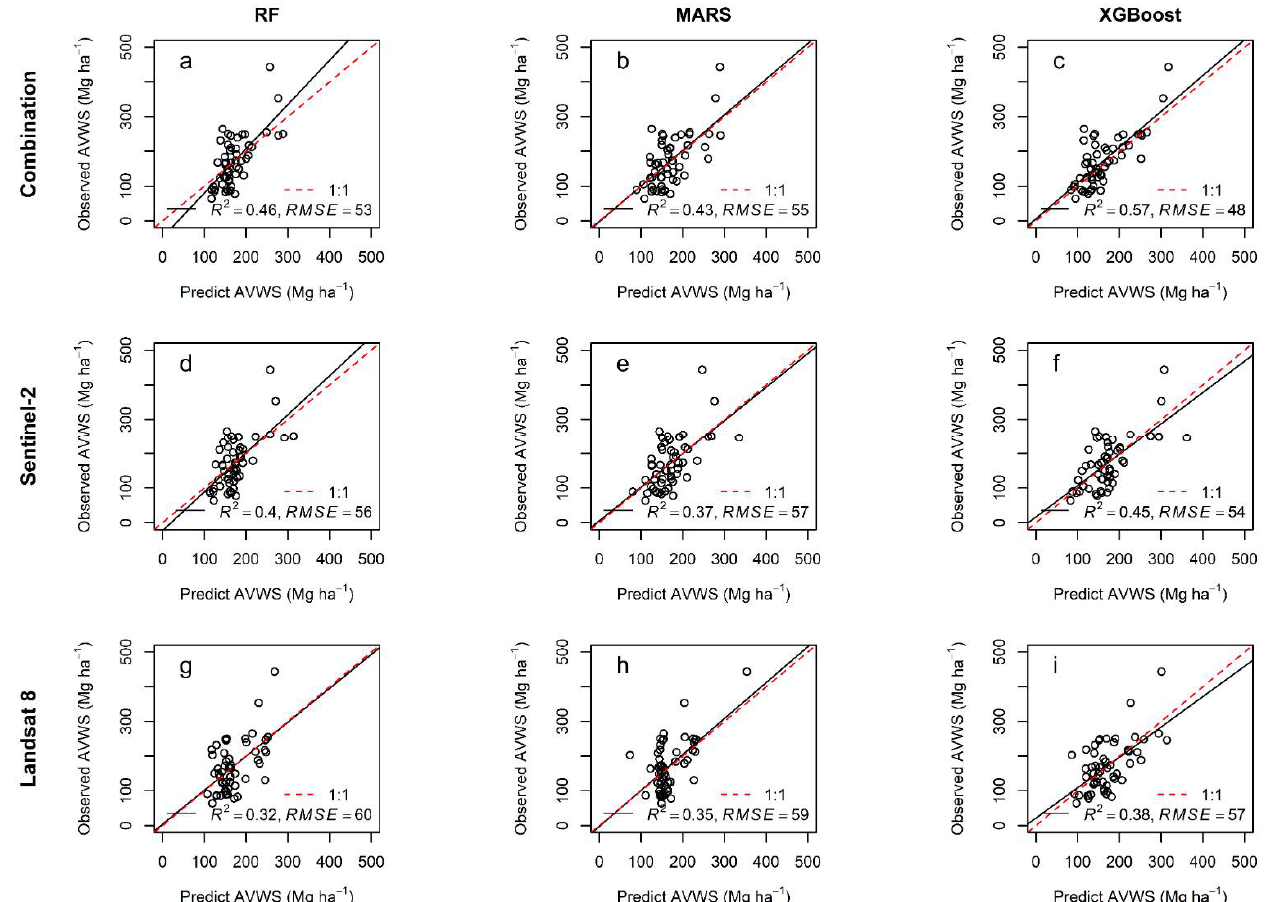
Figure 3. The correlation between predicted and observed aboveground vegetation water storage (AVWS) using different modelling approaches (XGBoost, RF and MARS) and satellite images (Landsat 8 and Sentinel-2). Table 2. Statistics of the aboveground vegetation water storage (AVWS) in the study